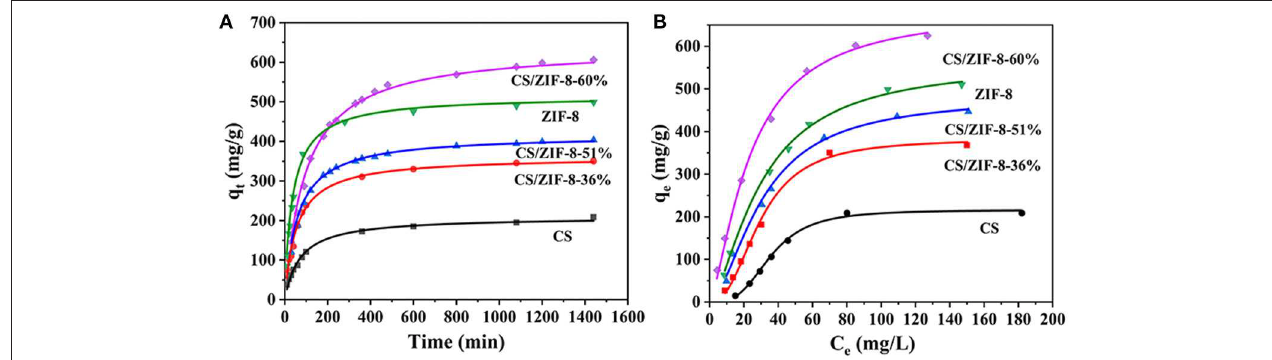
FIGURE 6 | Kinetic and isothermal studies of U(VI) adsorption process, fitted with second-order kinetics (A) and Langmuir models (B) respectively ( C 0 = 100 mg • L − 1 , pH = 3, t = 24h, m ads / V sol = 0.2 g • L − 1 ).